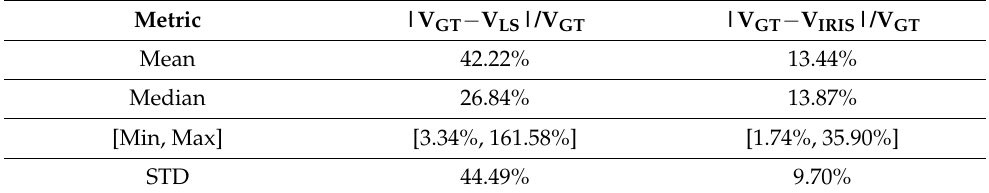
Table 3. Compared automatic LS segmented cyst volume (V LS ) and IRIS segmented cyst vol- ume (V IRIS ) against manual GT segmented cyst volume (V GT ). GT = ground truth segmentation, LS = automatic level set segmentation, and IRIS = intelligent rapid interactive segmentation. Metric